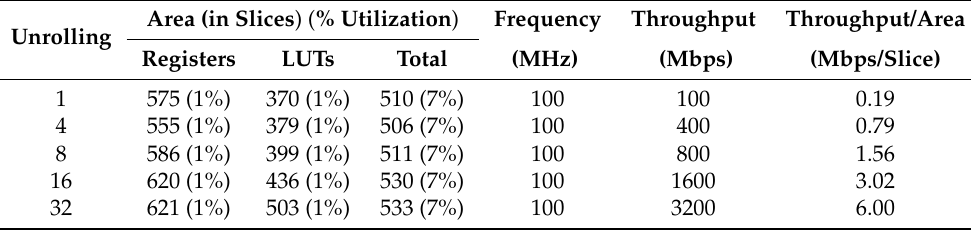
Table 12. Trivium synthesis results (Xilinx Spartan6, device XC6SLX45).